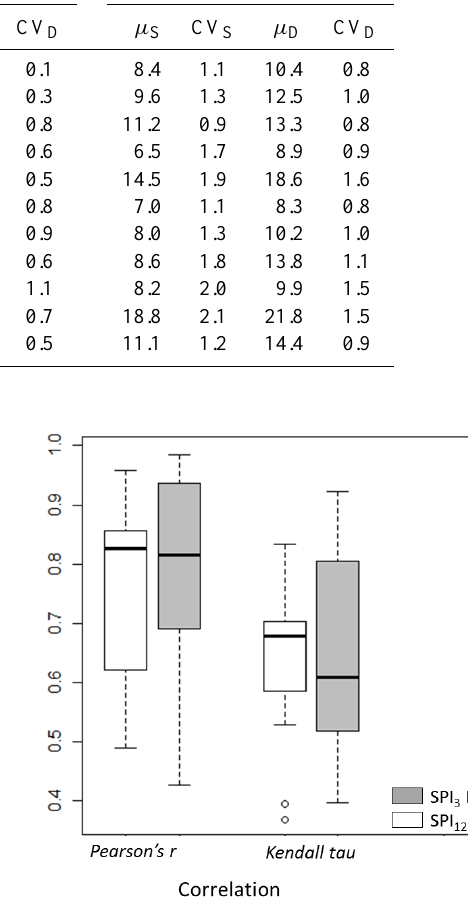
Figure 5. Correlation between SPI 3 and RDI 3 , and SPI 12 and SPEI 12 based on the correlation coefficient Pearson’s r and Kendall’s τ . The outliers represent the very dry locations of Bourke and